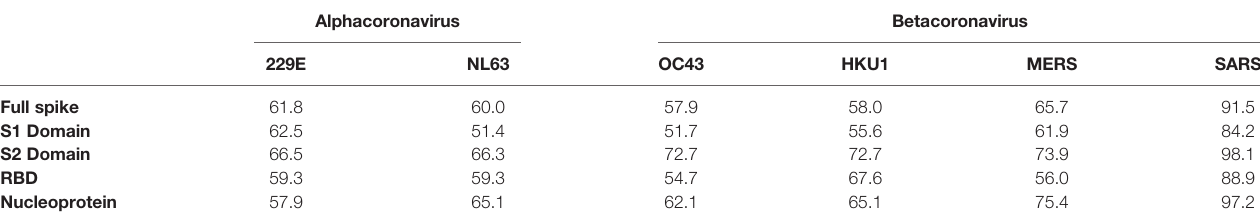
TABLE 2 | Percent similarity of amino acid sequences between human CoVs and